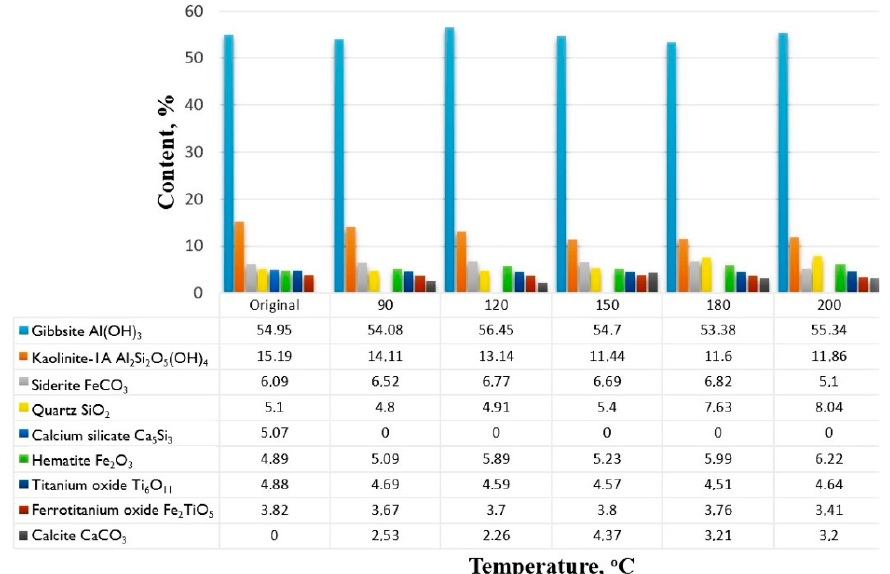
Figure 4. Phase composition of bauxite samples depending on the temperature of chemical activation.